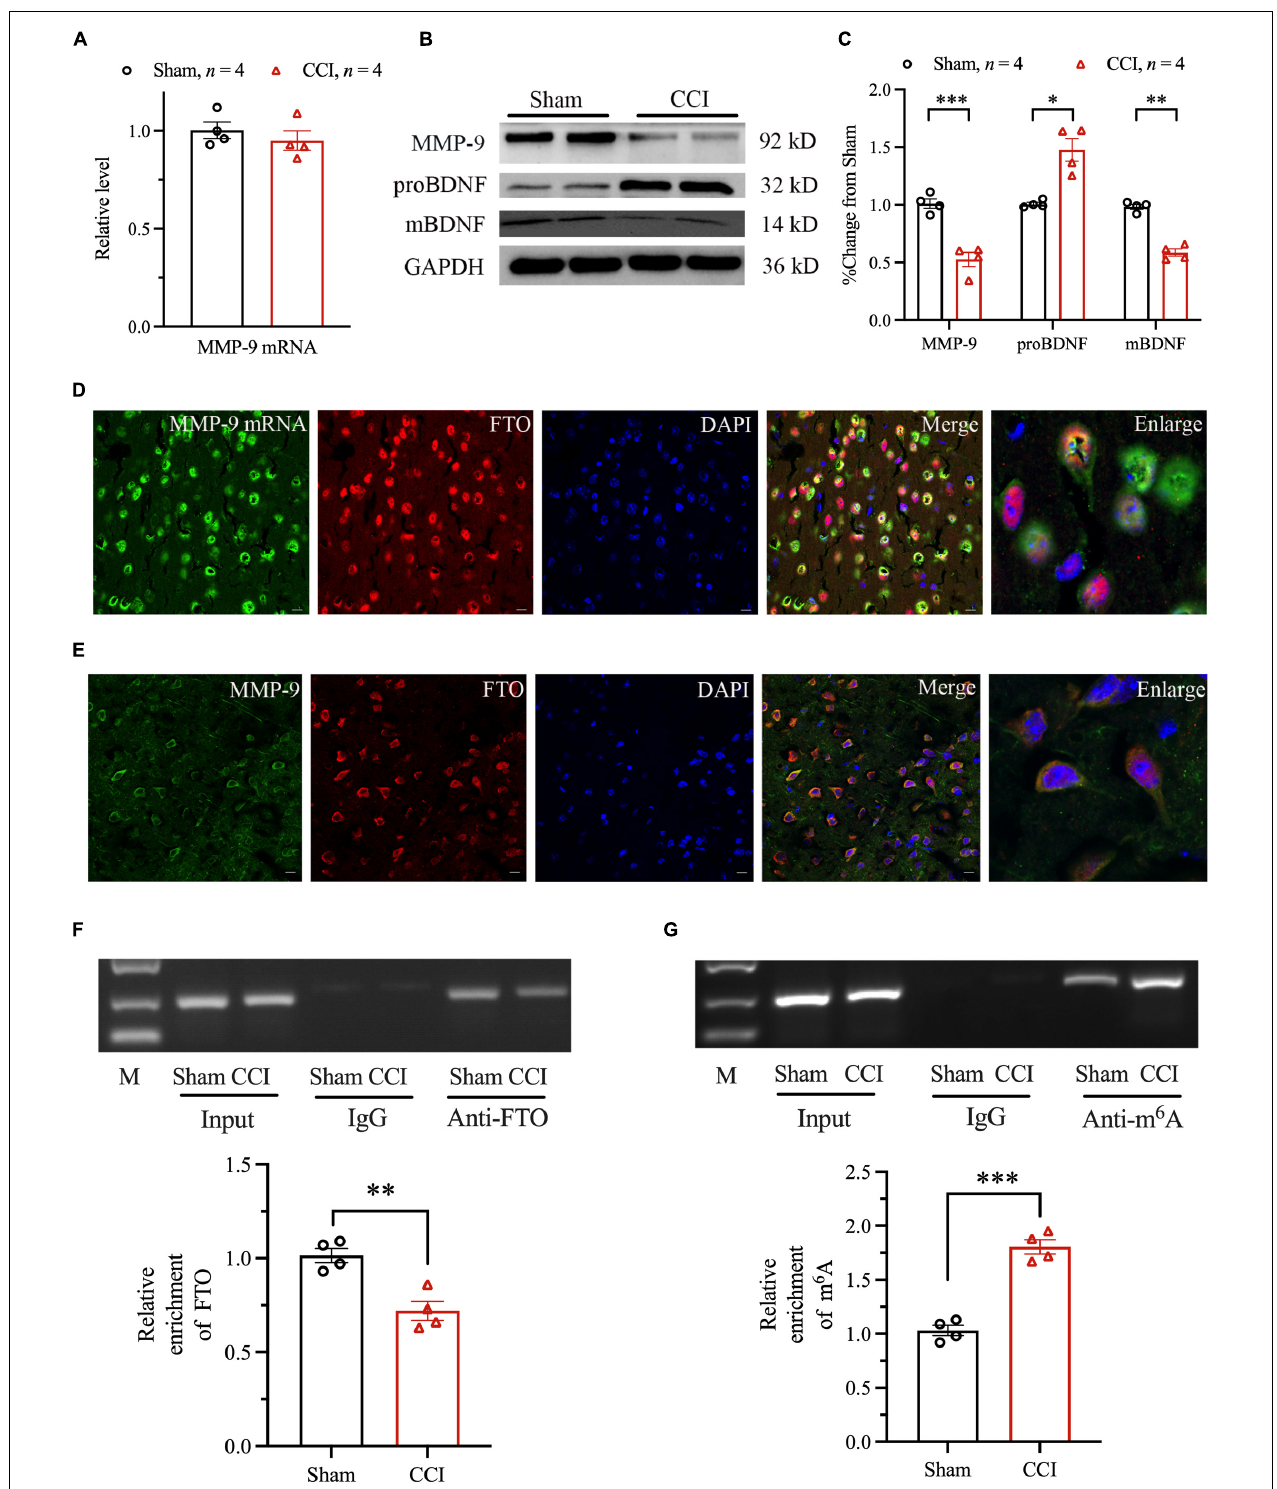
FIGURE 5 | The mechanism of FTO affecting the expression of MMP-9. (A) qRT-PCR results of the expression of MMP-9 mRNA in ACC of Sham and CCI mice. (B,C) Western blot results of the expression of MMP-9, proBDNF, and mBDNF ( ∗ P < 0.05, ∗∗ P < 0.01, ∗∗∗ P < 0.001 vs. Sham). (D) The representative images of the original hybridization of MMP-9 mRNA and co-labeling of FTO immunofluorescence in ACC. (E) The cellular expression patterns of FTO protein and MMP-9 protein. (F) RIP results of FTO and MMP-9 mRNA in ACC after CCI in mice ( ∗∗ P < 0.01 vs. Sham). (G) RIP results of m 6 A and MMP-9 mRNA in ACC after CCI in mice ( ∗∗∗ P < 0.001 vs.